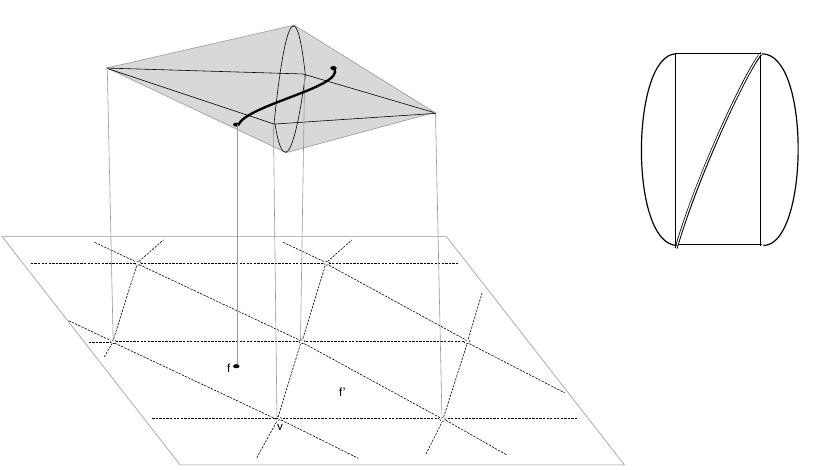
Figure 40 . Left: a very economical description of the operator U Y [ ‘ ] for adjacent faces f and f;f 0 f 0 . The pillow-case geometry is the minimal way to interpolate between triangulations with quasi- particle insertions at f and f 0 . Right: the decorated pillowcase is computed in the spherical fusion category by an appropriate planar graph including the appropriate center line corresponding to the quasi-particle. The quasi-particle joins the junctions dual to the bottom bi-pyramid face above f and the top bi-pyramid face above f 0 . We selected a speci(cid:12)c framing for the quasi-particle, pointing towards the vertex v